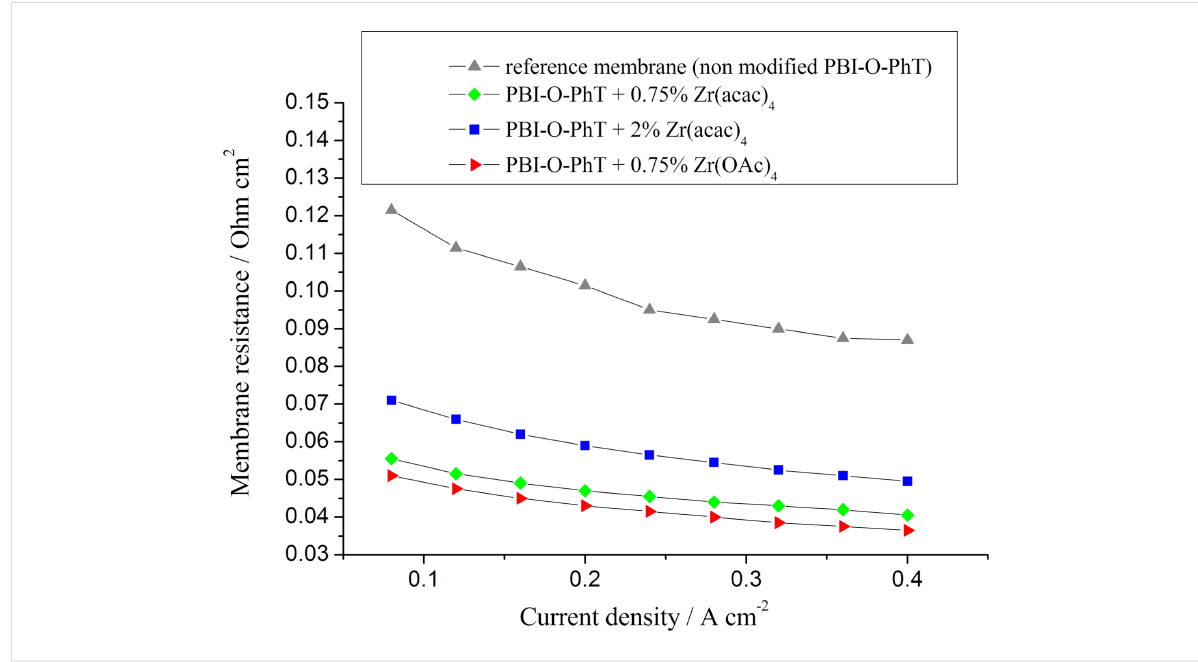
Figure 10: Membrane resistances as functions of the current density for fuel cells with different PBI membranes. T = 160 °C.